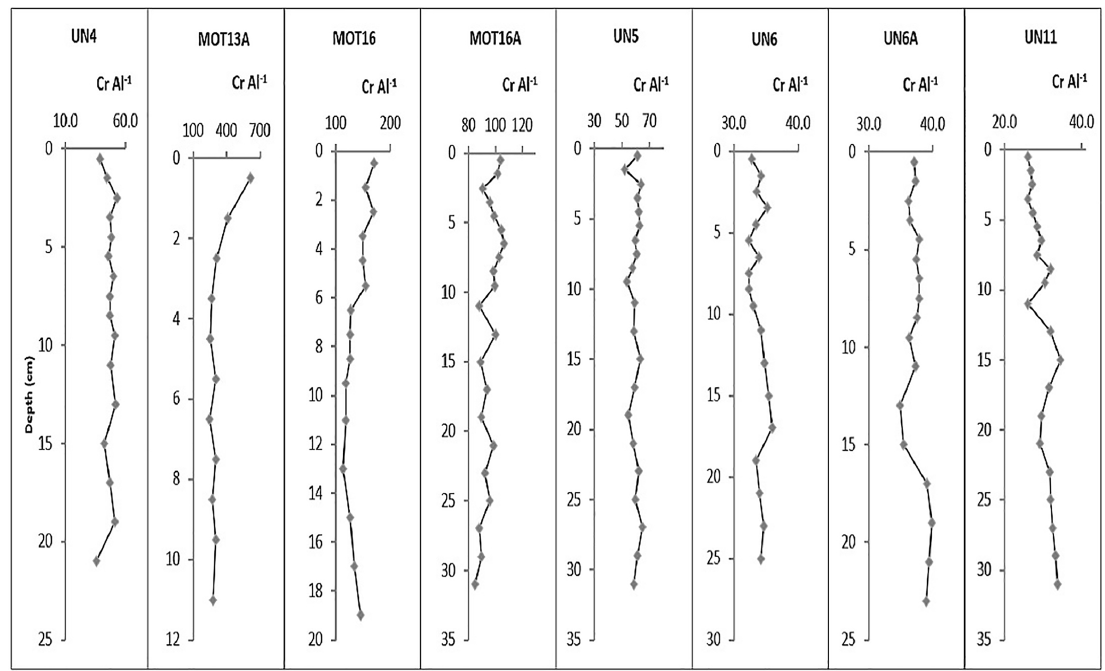
Figure A3. Vertical distributions of Cr Al − 1 × ( 10 4 ) in sediment cores. The ratios in the coarse cores MOT13A, MOT16 and UN4 are calculated at the fine-sediment fraction ( < 63µm).